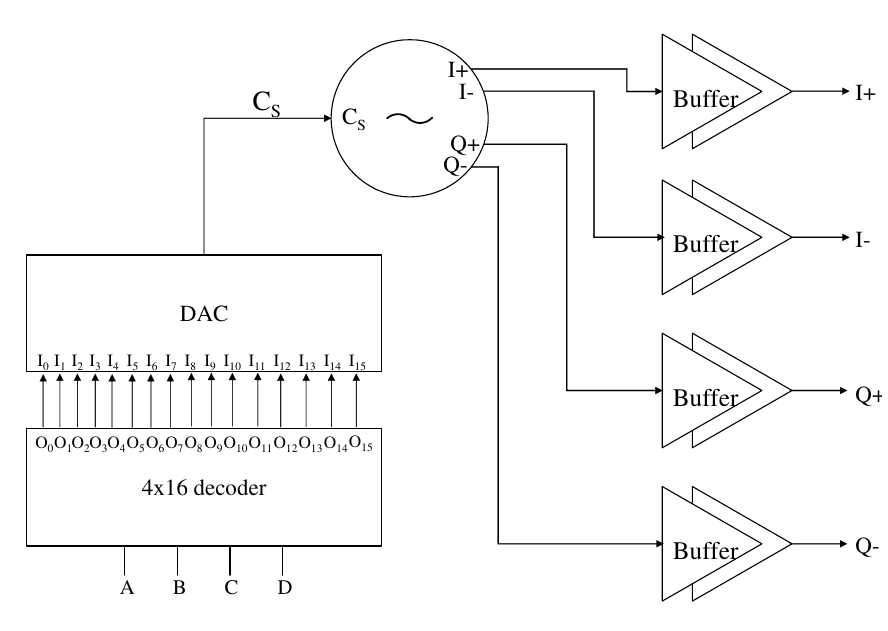
Figure 2. Block diagram of the DAC-based DCO [7]. The DAC-based DCO is designed differentially with four delay cells, which are controlled with the help of a control signal (C s ) from the DAC, as shown in Figure 3a. A cross-coupled architecture is chosen for the delay cell, as it provides better phase noise and jitter performance. The delay from the cross-coupled architecture is regulated by varying the node currents by the C s . A differential ring-oscillator structurem, as shown in Figure 3b, is chosen due to its high stability, strong robust against substrate and supply noise, and its capability to generate in-phase and quadrature signal components. C s is derived from the current source, a weighted transistor array, as shown in Figure 4. To obtain linear and fine-tuning of the DCO, the pMOS transistors are arranged in increasing order of their size. The size of the (n + 1)th pMOS transistor is increased by the step of the smallest size of the pMOS transistor. The frequency of oscillation increases as the size of the transistor increases, due to the higher current through the delay cells. C s is obtained from the nMOS transistor, which is always ON. This keeps the output capacitance of the DAC independent of the weighted pMOS transistors, which helps to change the oscillation frequency linearly. Each pMOS transistor in the DAC can be designed independently, as only one pMOS transistor becomes active at a given time. This grants the freedom to assign custom frequencies to a digital code, by tuning the size of the pMOS transistor. The control bits for the DAC can be directly obtained from the digital loop filter (DLF) or via a decoder. Obtaining the control bits directly from the DLF improves the resolution of the DCO to 6.10 kHz